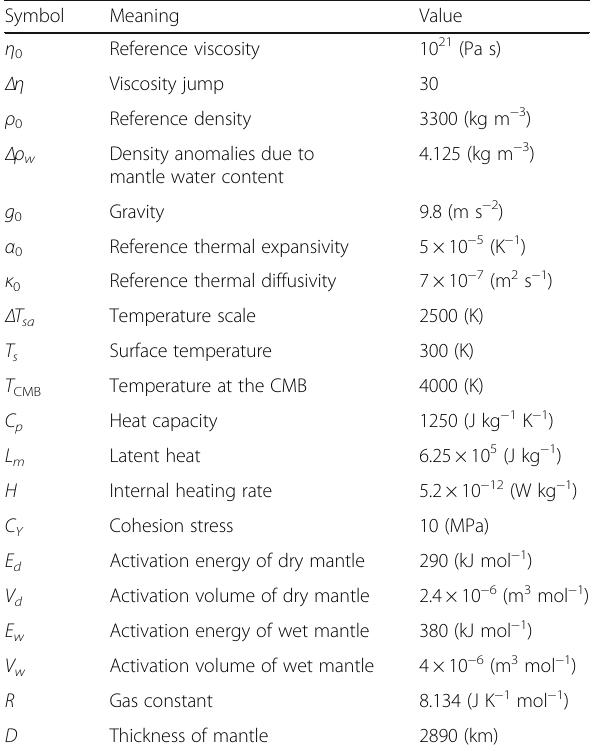
Table 1 Physical